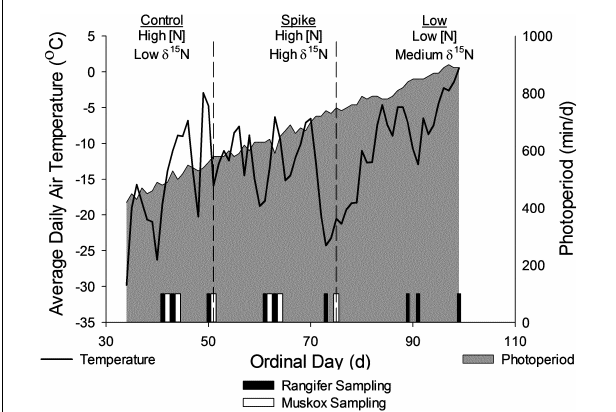
FIGURE 1 | Environmental conditions for experiments on female reindeer, caribou ( Rangifer ) and muskoxen ( Ovibos ) during late winter from February to April of 2009 in Fairbanks, AK, United States. Reindeer and caribou were fed all three rations as complete diets whereas muskoxen were fed hay ad libitum , which was supplemented with the control or the spike rations. Sampling days for collection of blood and excreta and for measures of body condition are indicated as vertical bars on the X -axis.